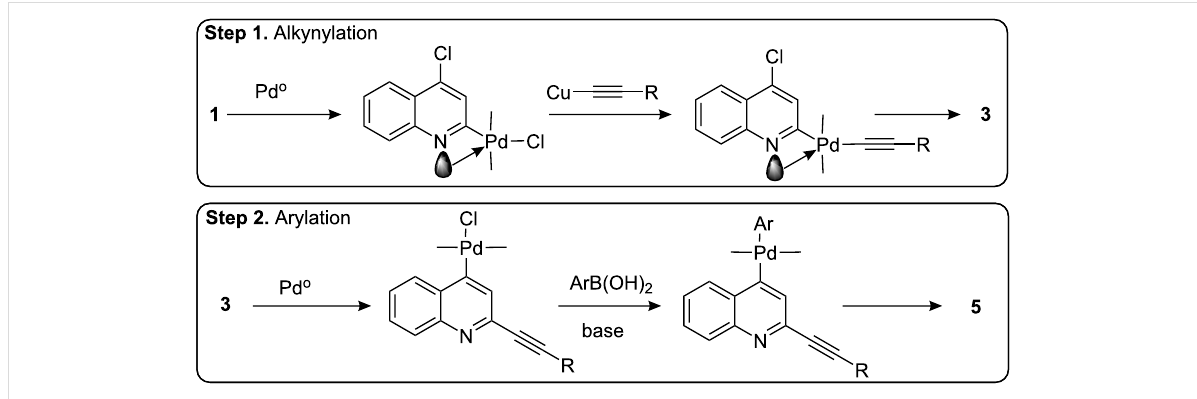
Scheme 2: The reaction mechanism of stepwise C–C bond forming